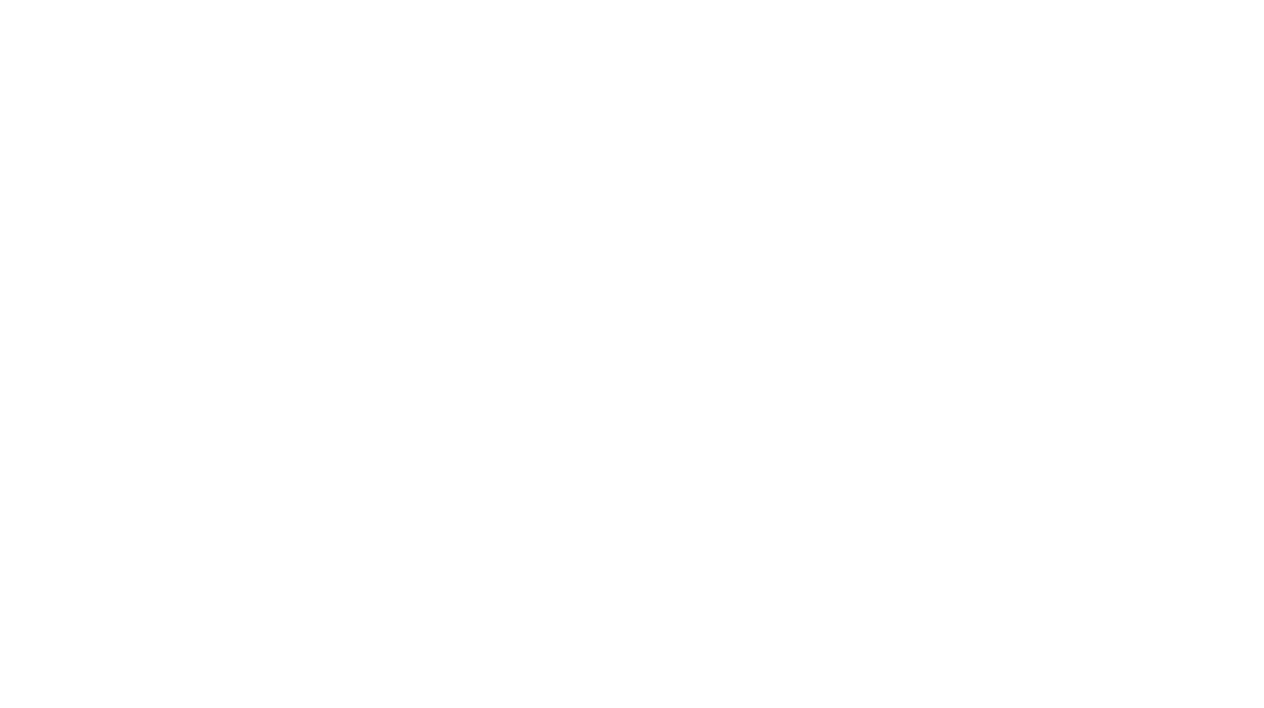
FIGURE 4 | Sevo fl urane alleviates in fl ammatory cell in fi ltration in MIRI rats. (A) The expression of CD11b in rat myocardial tissue determined by immuno fl uorescence staining (n = 6, Scale bars 20 µm). (B) Effects of Sevo fl urane at different concentrations on the release of IL-1 β and IL-18 in myocardial tissue after MIRI. All values are expressed as means ± SD (n = 6). * p < 0.05, ** p < 0.01, *** p < 0.001 vs. respective controls. (C) Expression of NLRP3 in rat myocardial tissue by immunohistochemical staining of normal perfusion, MIRI and sevo fl urane treatment with different concentrations in rats (n = 6, Scale bars 20 µm). (D) The ExpressionofGSDMDinratmyocardialtissuebyimmunohistochemicalstainingofnormalperfusion,MIRIandsevo fl uranetreatmentwithdifferentconcentrationsinrats (n = 6, Scale bars 20 µm). Data are expressed relative to the mean value for sham group and were presented as mean ± SD. * p < 0.05, ** p < 0.01, *** p < 0.001 vs. respective